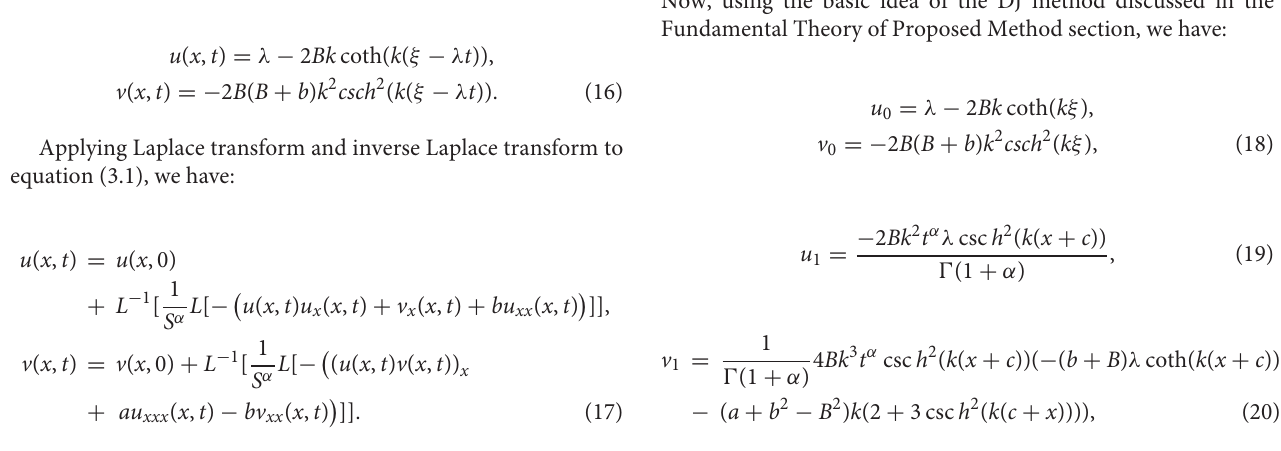
1 for MB equation. =